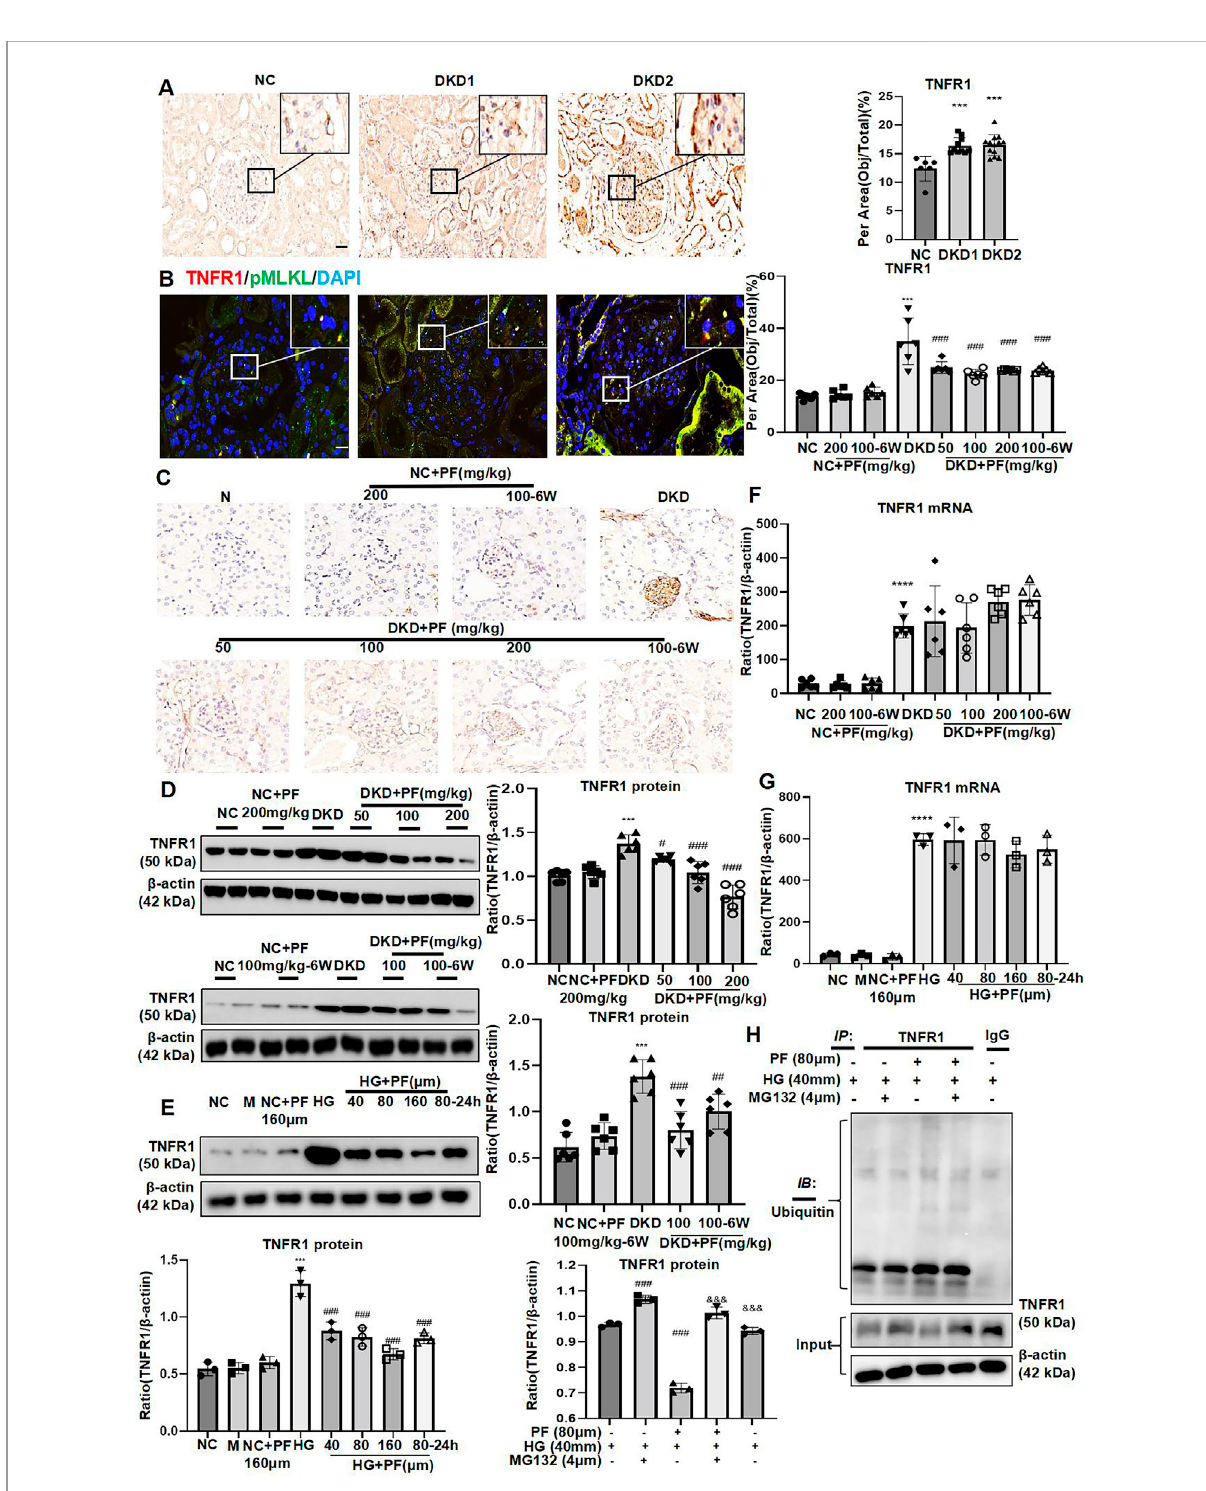
FIGURE 8 PF regulates TNFR1 protein expression in vivo and in vitro . (A) IHC assay of TNFR1 protein expression on the glomerulus of human renal biopsy tissues. Scale bar = 20 μ m. (B) IF double staining for p-MLKL and TNFR1 in human renal biopsy tissues. Scale bar = 20 μ m. (C) IHC assay of TNFR1 protein expression on the glomerulus in STZ-induced diabetic mice. Scale bar = 50 μ m. (D) WB assay of TNFR1 protein in STZ-induced diabetic mice. (E) WB assay of TNFR1 protein in MPC5 with HG and PF treatment. (F) The levels of TNFR1 mRNA in STZ-induced diabetic mice. (G) The levels of TNFR1 mRNA in MPC5 with HG and PF treatment. (H) The ubiquitination of TNFR1 in MPC cells. Results represent the mean ± SD. ** p < 0.01, *** p < 0.001 vs. NC; # p < 0.05, ## p < 0.01, ### p < 0.001 vs. HG/DKD; &&& p < 0.001 vs. HG+PF. NC, normal control (5.5 mmol/L